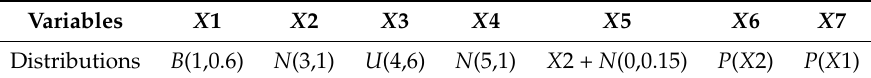
Table 2. Input variables for linear model.